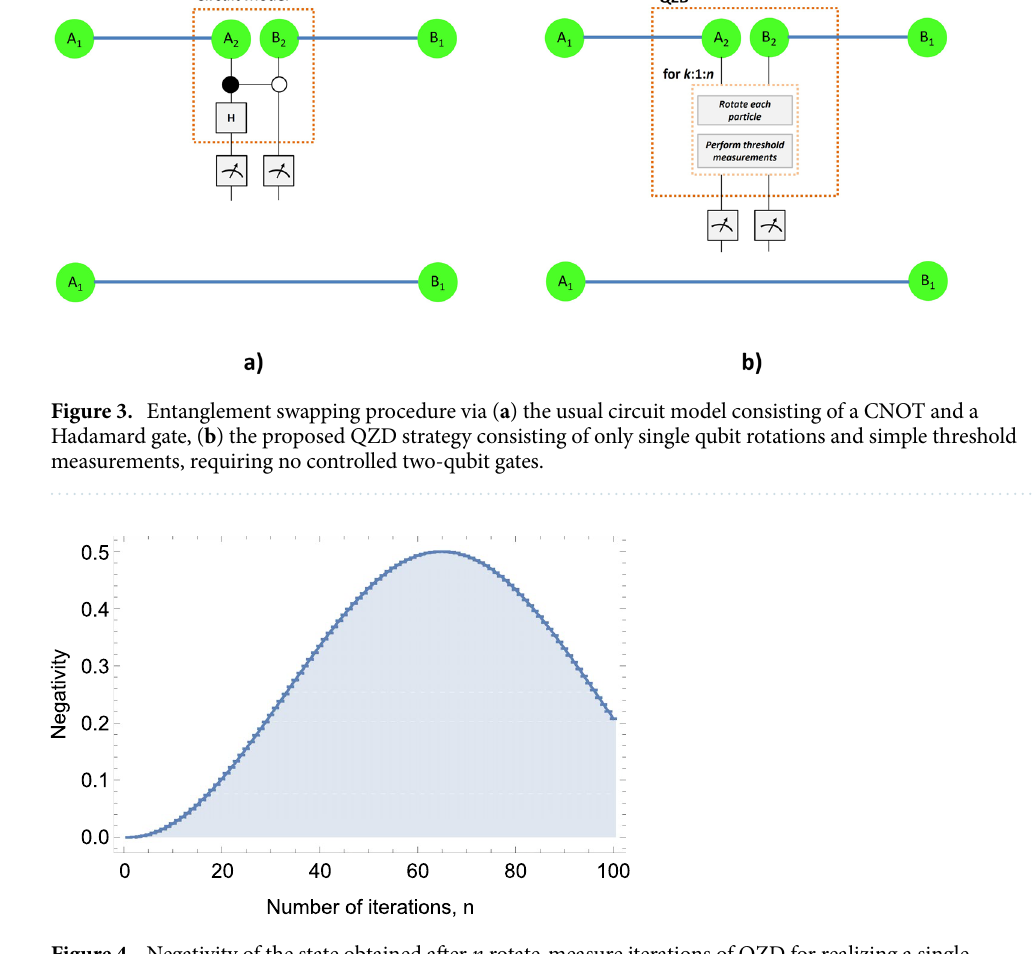
Figure 4. Negativity of the state obtained after n rotate-measure iterations of QZD for realizing a single entanglement swapping as in Fig.